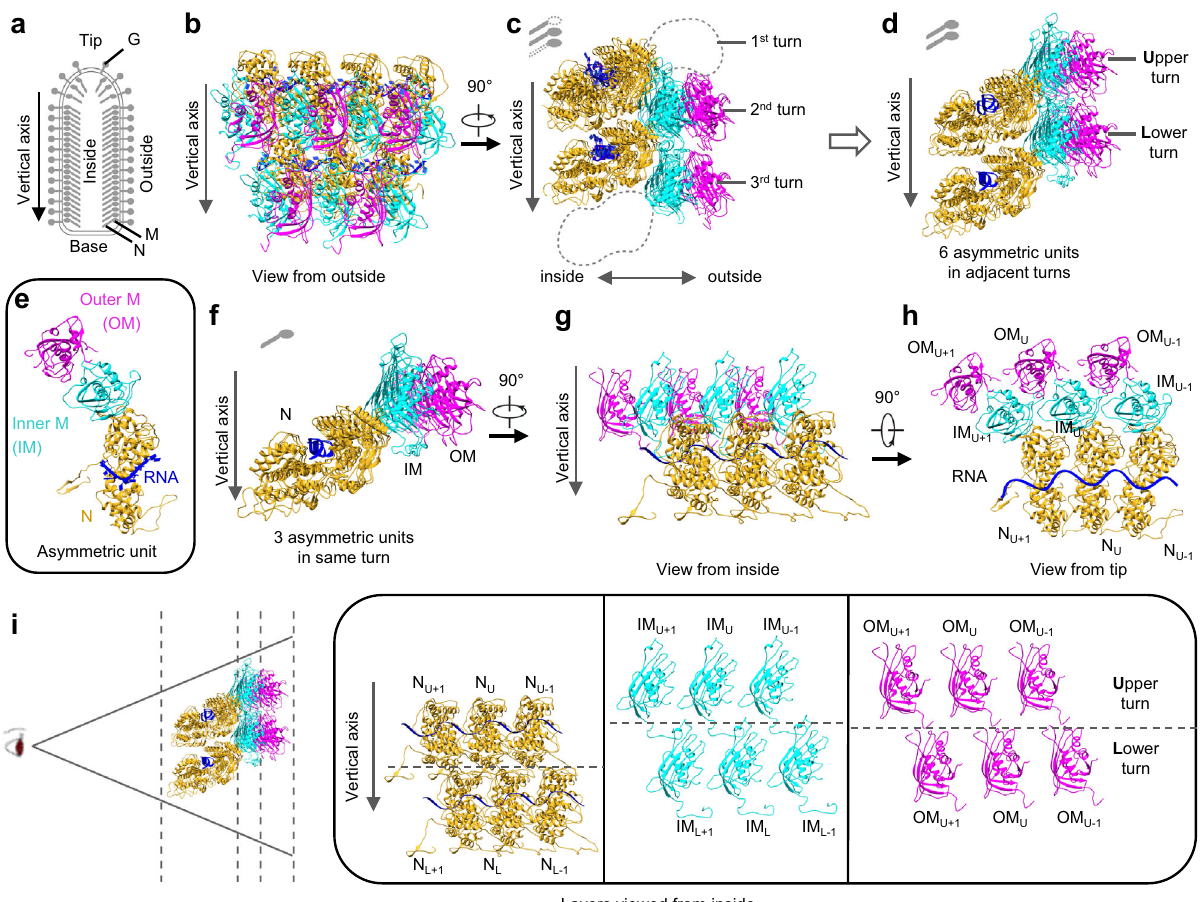
Fig. 2 | Atomic model of the partial VSV nucleocapsid. a Schematic diagram of the VSV virion. b , c Twoorthogonalviewsofthe atomic model,which contains 7N (goldenrod),7inner M(cyan)and 5outer M(magenta).Only intactN, intactMand RNA are built and colored,as in the cryoEM map. d Six asymmetric units from two turns derived from ( c ). e One asymmetric unit, including 1N, 1 IM and 1 OM,